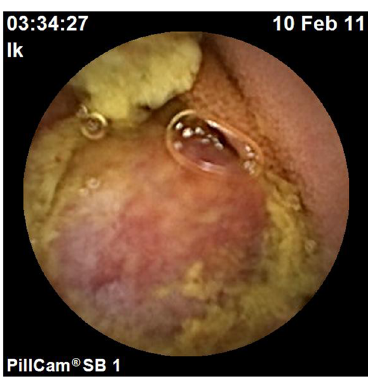
Figure 3. Roundworm detected by CE. Roundworm was detected by CE in the small bowel in a 49-year-old woman with periumbilial pain for more than one year.